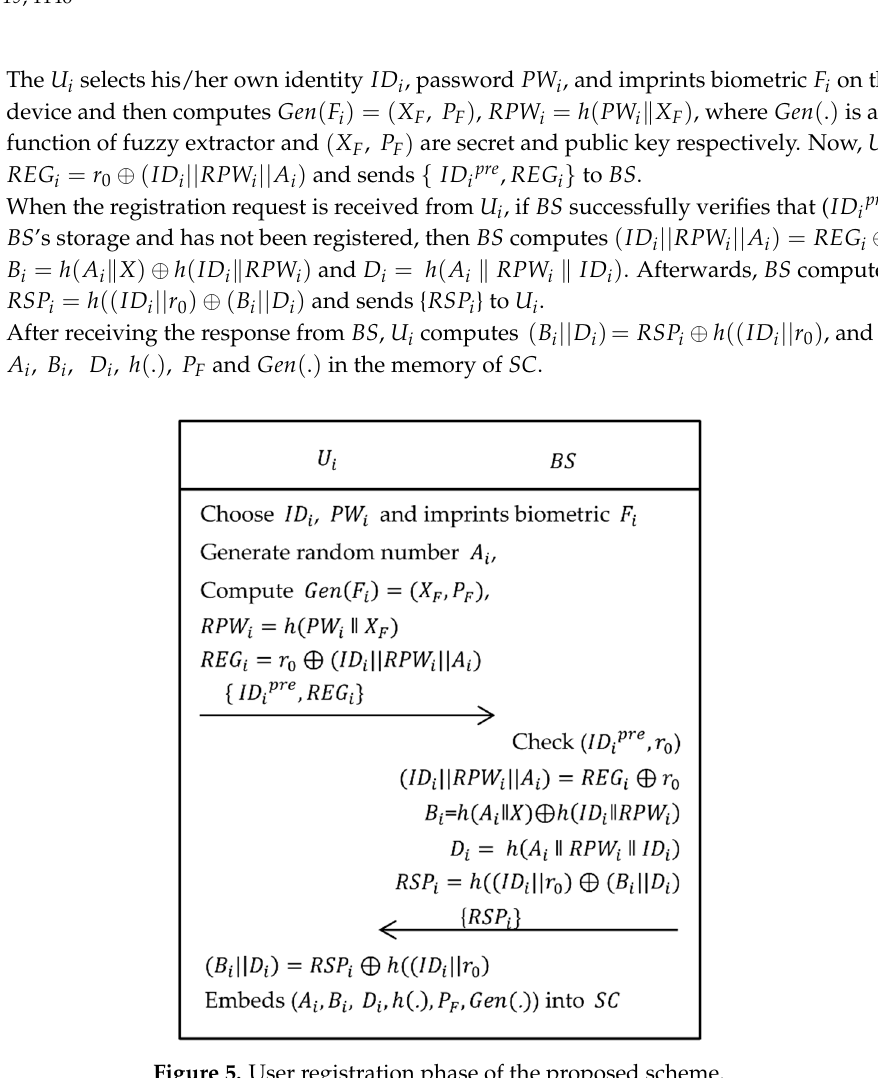
Figure 5. User registration phase of the proposed scheme.